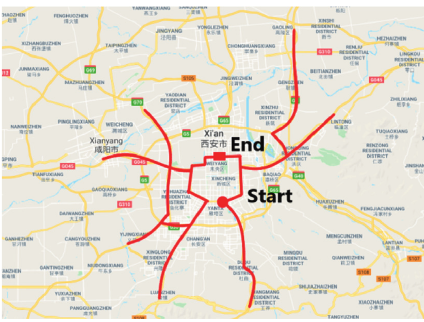
Figure 18: Validation data collection route. Table 4: Cascade model structure during validation.